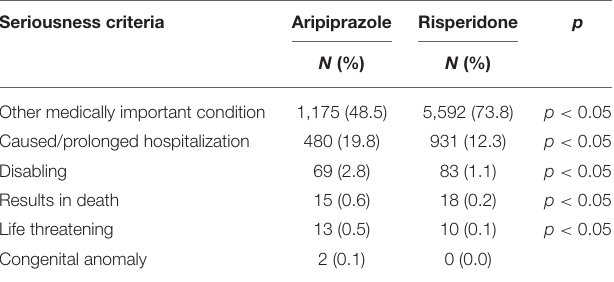
TABLE 2 | Distribution of seriousness criteria selected for the adverse events reported for Risperidone and